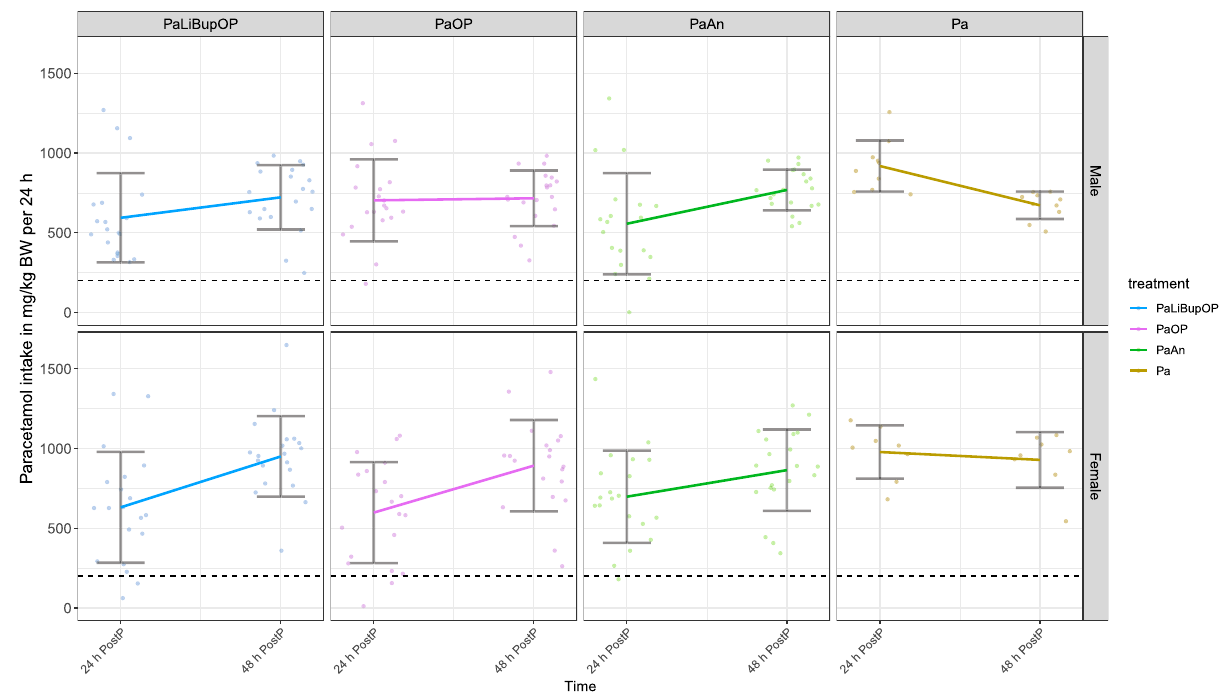
Figure 3. Paracetamol intake in mg/kg body weight per 24 h for male and female mice in each treatment group that received Paracetamol. Data are shown as a scatter dot plot with mean ± SD for the first 24 h (24 h post- procedure) and the second 24 h after the procedure (48 h post-procedure). The dashed line marks the target dose of 200 mg/kg body weight per 24 h. Numbers per group: PaLiBupOP, PaOP and PaAn n = 20/each sex; Pa male n = 10, Pa female n =